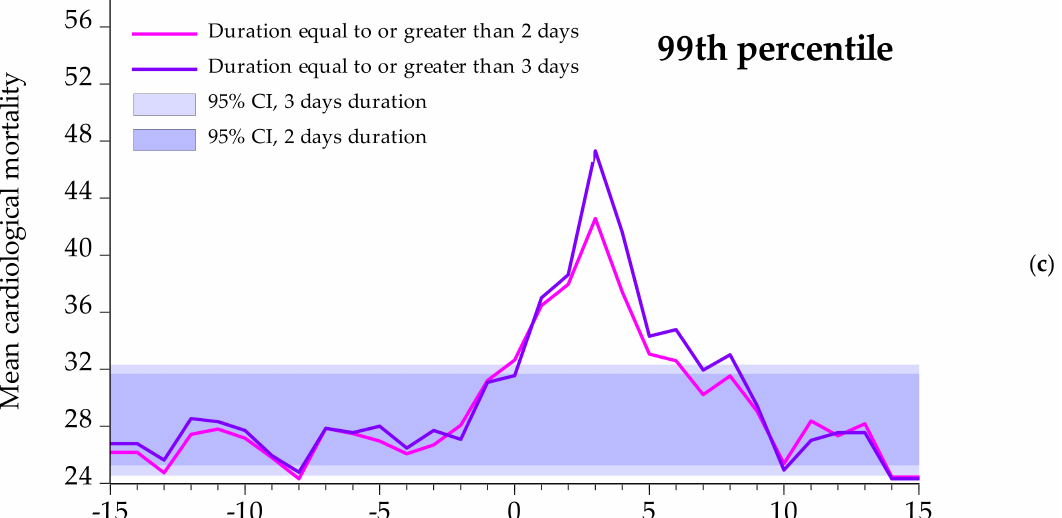
Figure 6. Superposed Epoch analysis for mortality due to cardiological diseases for duration of the heatwave event of at least 2 and 3 days: ( a ) 95th percentile; ( b ) 97.5th percentile; ( c ) 99th percentile. Notes: (i) The shaded area shows the 95% Confidence Interval (CI), (ii) the vertical axis measures the mean number of deaths due to cardiological diseases, (iii) the horizontal axis depicts the time 15 days before and 15 days after the heatwave event. Day 0 is the first day of the